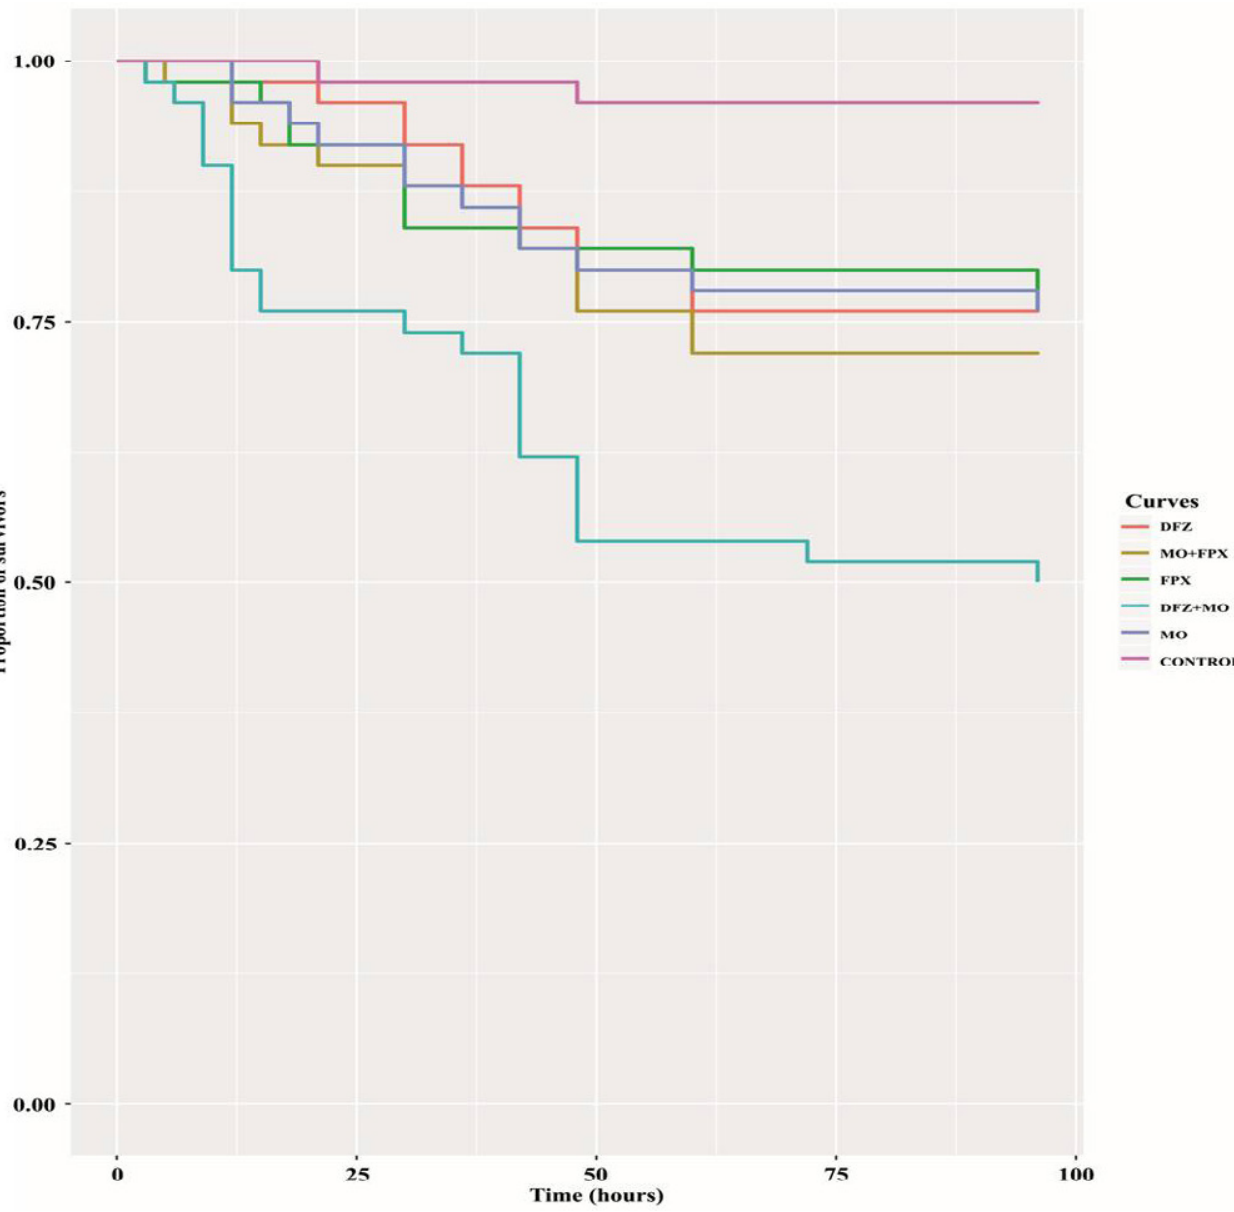
Fig 2 . Survival curves plotted from exposure time (hours) via contact until death of each bee ( Apis mellifera ): Difenoconazole (DFZ); Mineral Oil + Fenpyroximate (MO+FPX); Fenpyroximate (FPX); Difenoconazole + Mineral Oil (DFZ+MO); Mineral Oil (MO); Control (CONTROL). Curves indicate the median and 95%,